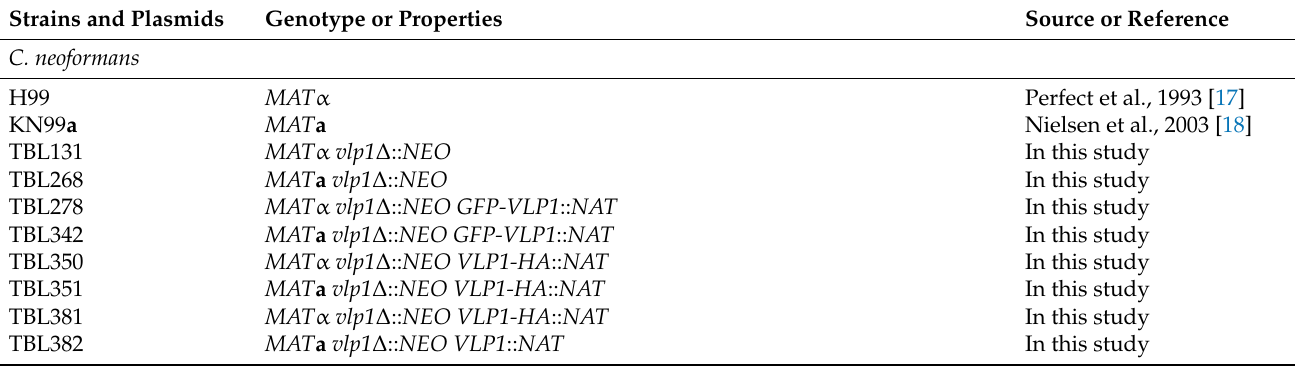
Table 1. Strains and plasmids used in this